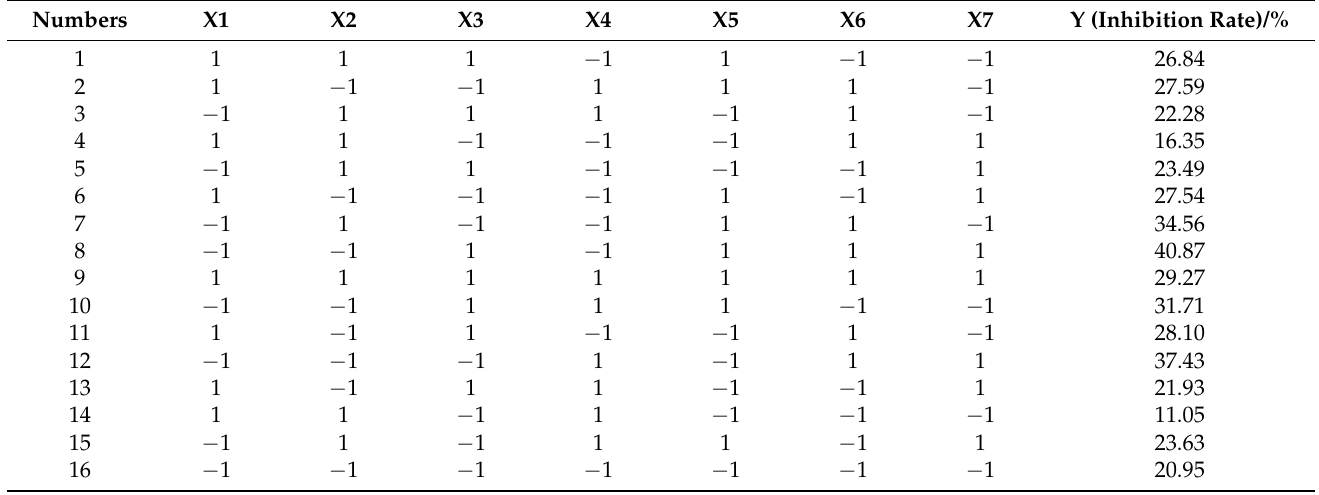
Table 4. Plackett–Burman experimental design and response value.